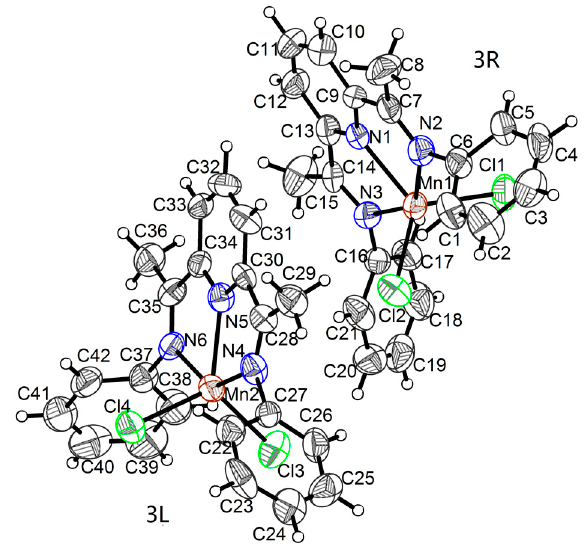
Figure 3. The molecular structure and crystallographic numbering scheme for complex 3 (CH 3 CN molecules are omitted for clarity).